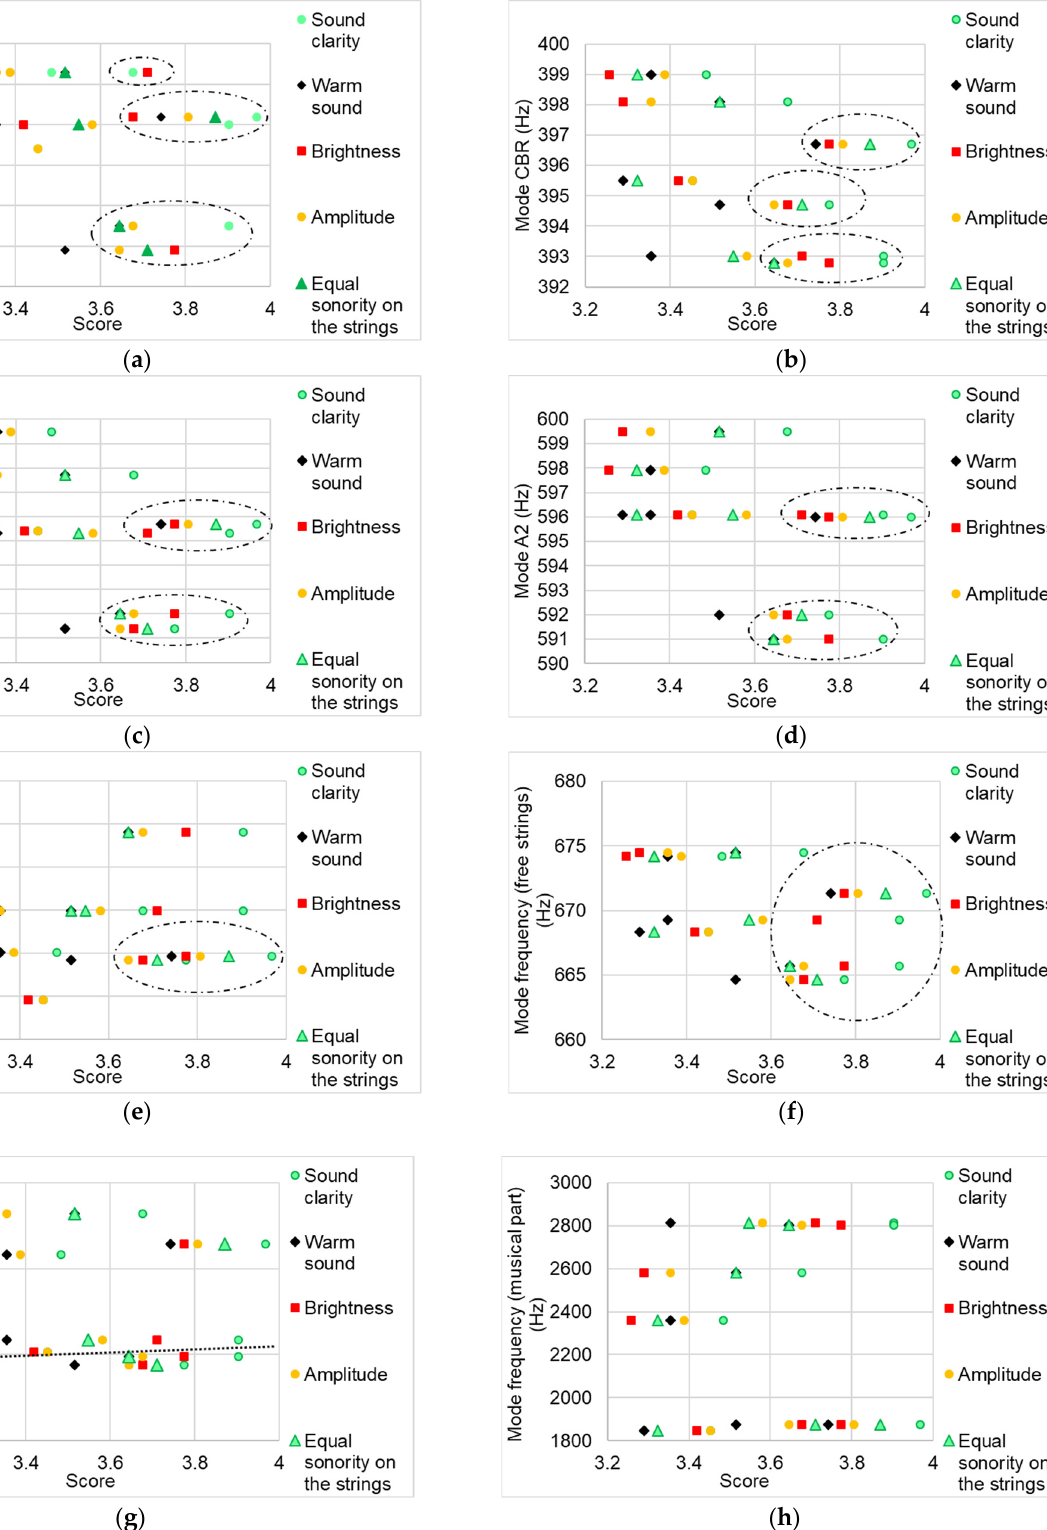
Figure 11. The correlation between the scores obtained for each criterion and signature modes: ( a ) mode A0; ( b ) mode CBR; ( c ) mode B1-; ( d ) mode A2; ( e ) dominant frequency; ( f ) mode frequency– free strings; ( g ) mode frequency–Pizzicato; ( h ) mode frequency–musical part.